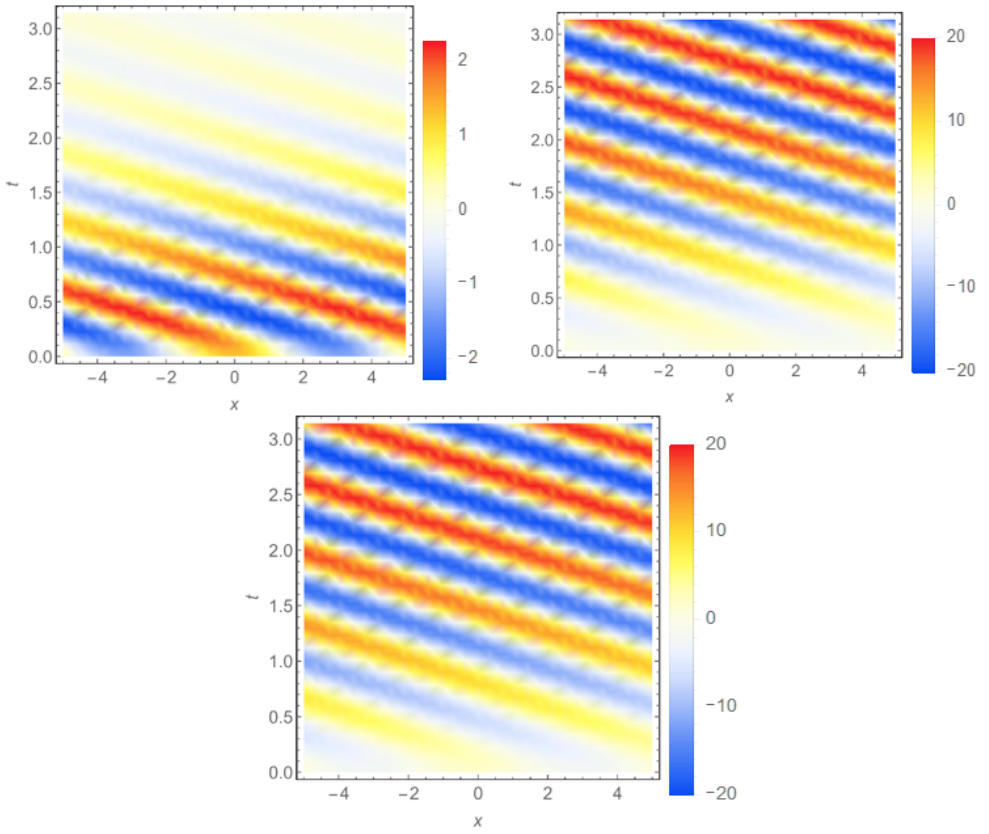
Figure 3. Evolution of quasi-temperature components in a thin film with Kn b = Kn d = 1 for v = − 10: θ b ( x , t ) —top left plot, θ d ( x , t ) —top right plot and θ ( x , t ) = θ b ( x , t ) + θ d ( x , t ) —bottom plot. The Cauchy conditions for PDEs (9) and (10) system are θ b ( x ,0 ) = θ d ( x ,0 ) = e inx , ∂ t θ b ( x ,0 ) = ∂ t θ d ( x ,0 ) = 0. Note, that for Kn b = Kn d = 0.1 θ b ( x , t ) and θ d ( x , t ) constituents behave differently (see Figure 10 v = the complete quasi-temperature ( ) txtxtx ,,, θθθ += db